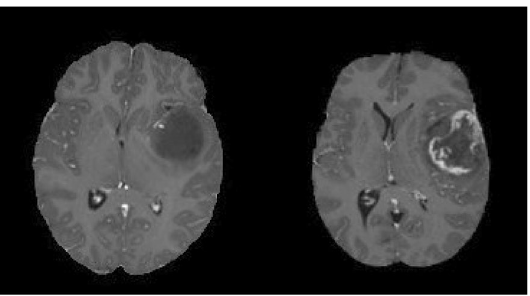
Figure 1. An example MRI of Low-grade glioma (LGG, on the left) and High-grade glioma (HGG, on the right). Source: BraTS 2019.